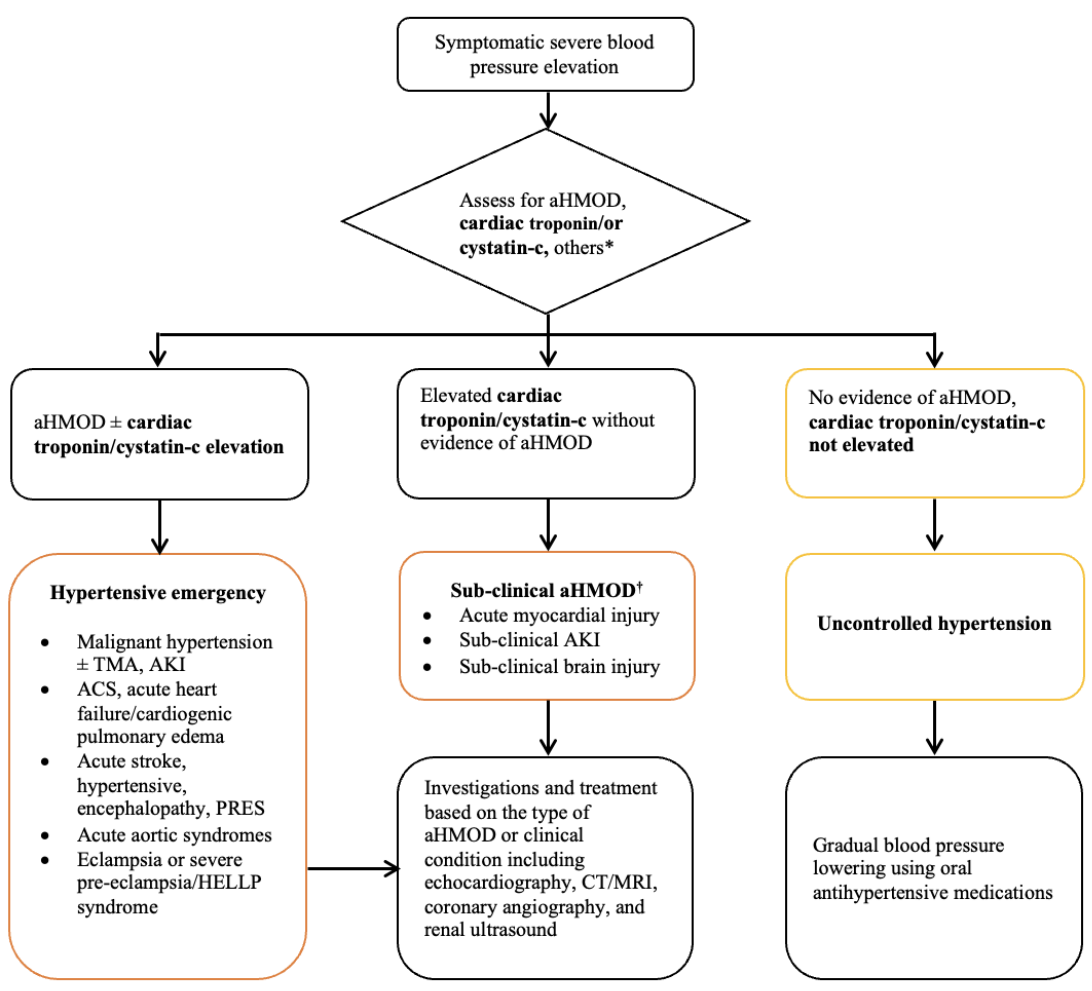
Figure 2. Algorithm for evaluation and classification of hypertensive emergencies. † Not listed as target organ damage in guidelines. ACS, acute coronary syndrome; AKI, acute kidney injury; aHMOD, acute hypertension-mediated organ damage; HELLP, hemolysis elevated liver enzymes or low platelets; PRES, posterior reversible encephalopathy syndrome; TMA, thrombotic microangiopathy. * Others—hemoglobin, platelet, lactic dehydrogenase, haptoglobin, creatinine, sodium, potassium, quantitative urinalysis for protein, urine sediments, ECG, chest X-ray, fundoscopy. Modified from van den Born et al. [5].